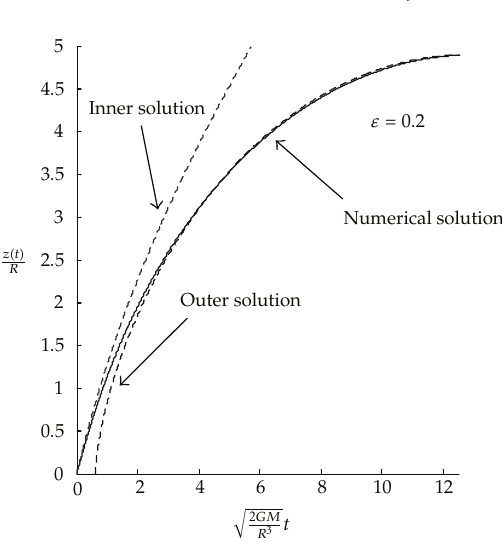
Figure 3: The function z (cid:4) t (cid:5) in the first quarter period of the orbit, with ε (cid:7) 0 . 2. Solid line corresponds to numerical integration of (cid:4) 3.1 (cid:5) , the dashed line represents the outer and the inner solution.